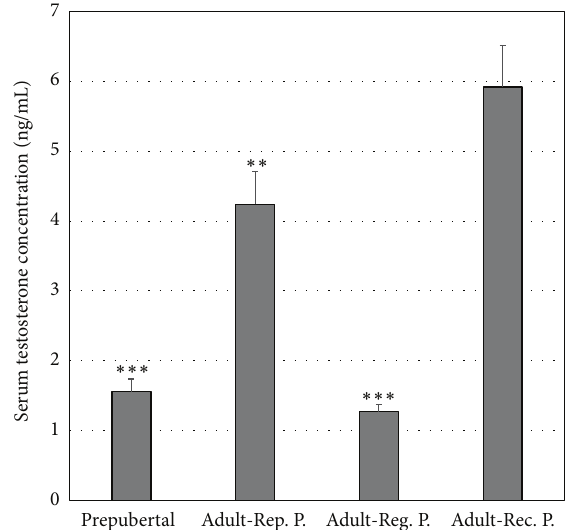
Figure 6: Testosterone serum concentrations. The values are expressed as mean ± SEM ( 𝑛 = 4 ). ∗∗ 𝑃 < 0.01 : Adult-Rep. P. versus Adult-Reg. P.; ∗∗∗ 𝑃 < 0.001 : prepubertal versus Adult-Rep. P.; Adult-Reg. P. versus Adult-Rec. P.